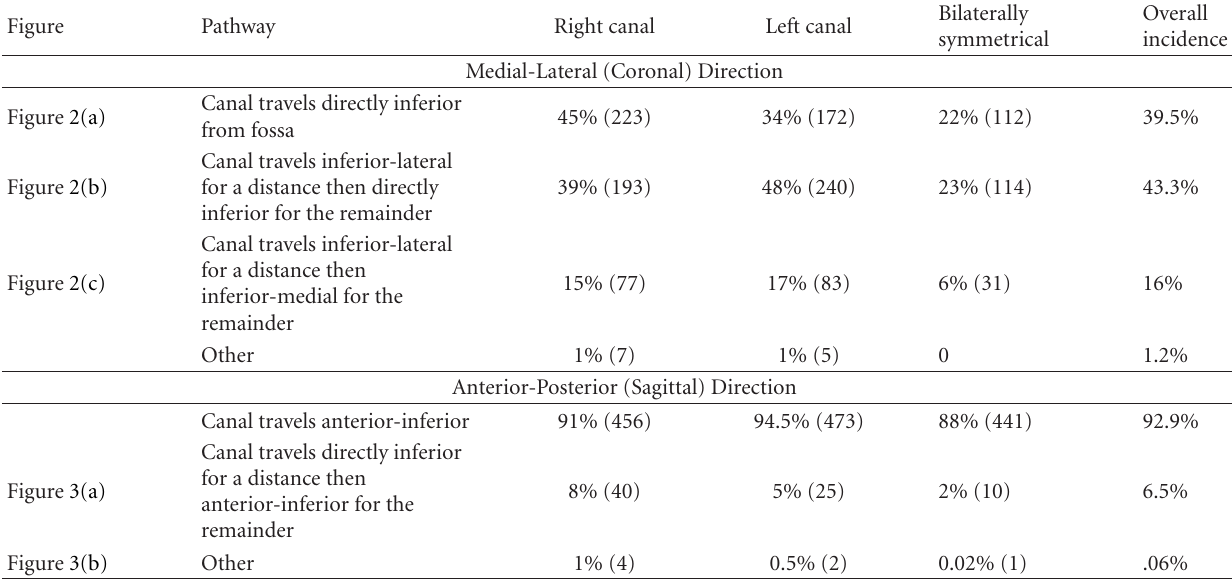
Table 1: Incidence of pathways of greater palatine canal. The table below summarizes the frequency of canal pathways observed in both the medial-lateral and anterior-posterior planes, unilaterally (out of each 500 right and 500 left), bilateral symmetry (out of 500 pairs), and overall incidence (out of 1000 right and left